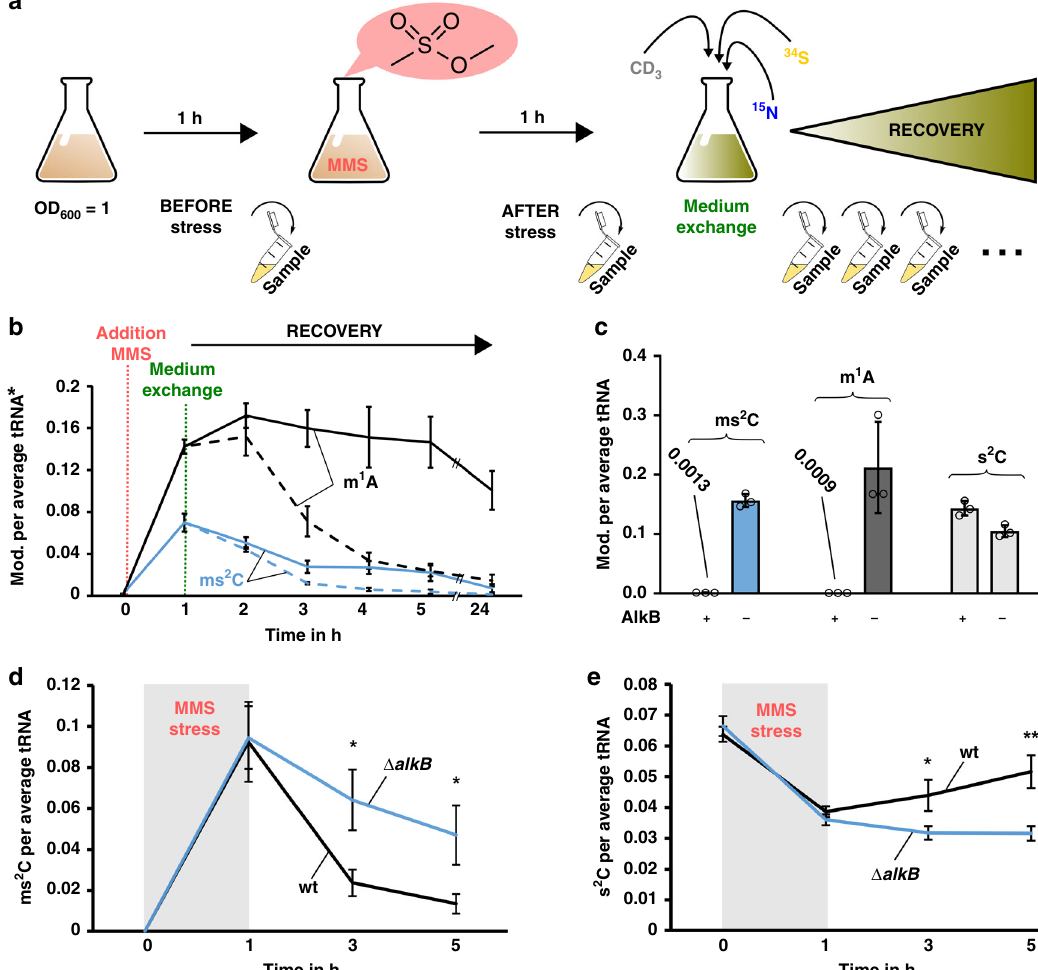
Fig. 4 Principle and results of pulse-chase NAIL-MS experiments to determine the repair of ms 2 C in vivo. a Principle of a pulse-chase NAIL-MS experiment. The bacteria are grown in unlabeled (n.l.) media before and after exposure to MMS (structure shown). After 1 h MMS exposure, the media is removed and fresh, [ 15 N], [ 34 S] and [CD 3 ]-methionine containing media is added. Samples are drawn during the recovery time for tRNA isolation. b Formation of the nucleoside damage product ms 2 C (blue) and m 1 A (black) per average tRNA after 20 mM MMS exposure. *Dashed lines: abundance of mod. (ms 2 C and m 1 A) per all tRNAs (sum of original, unlabeled and new, [ 15 N]-labeled transcripts). Solid lines: abundance of mod. (ms 2 C and m 1 A) per original tRNA. c Abundance of mod. (ms 2 C in blue, m 1 A in dark gray and s 2 C in light gray) per tRNA incubated with puri fi ed AlkB in vitro. The substrate tRNA is isolated from E. coli bacteria exposed to 20 mM MMS. d ms 2 C abundance of E. coli WT (black) in comparison to alkB de fi cient E. coli ( Δ alkB , blue) after MMS stress (20 mM, 1 h) and during recovery in a pulse-chase NAIL-MS experiment, as described in a) and b). e s 2 C abundance of E. coli WT (black) in comparison to alkB de fi cient E. coli ( Δ alkB , blue) after MMS stress (20 mM, 1 h) and during recovery. All experiments are from n = 3 biol. replicates and error bars re fl ect standard deviation. p -values from student t-test (equal distribution, two-sided): * p < 0.05 and ** p < 0.01. Source data are provided as a Source Data fi